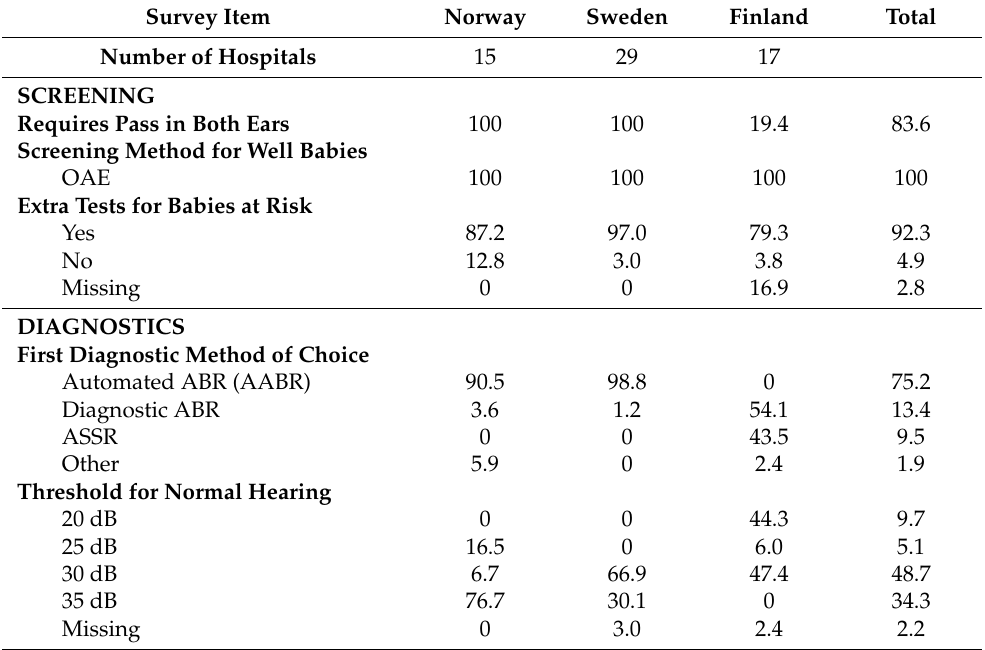
Table 1. Results from the questionnaire in percentages by childbirth coverage. Survey